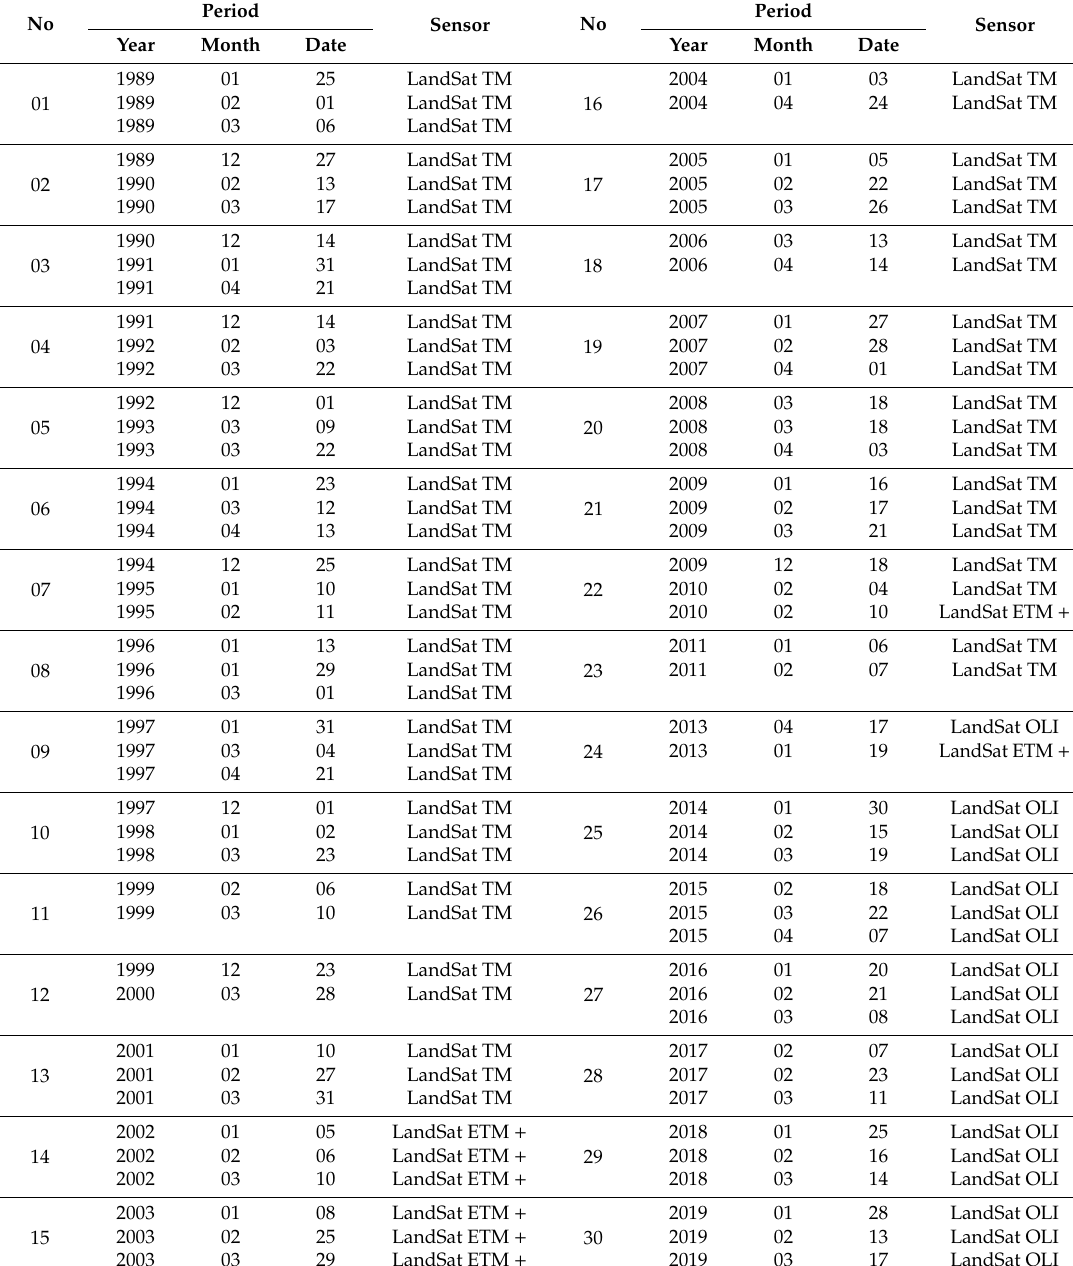
Table 1. List of processed Landsat images for the Bac Binh